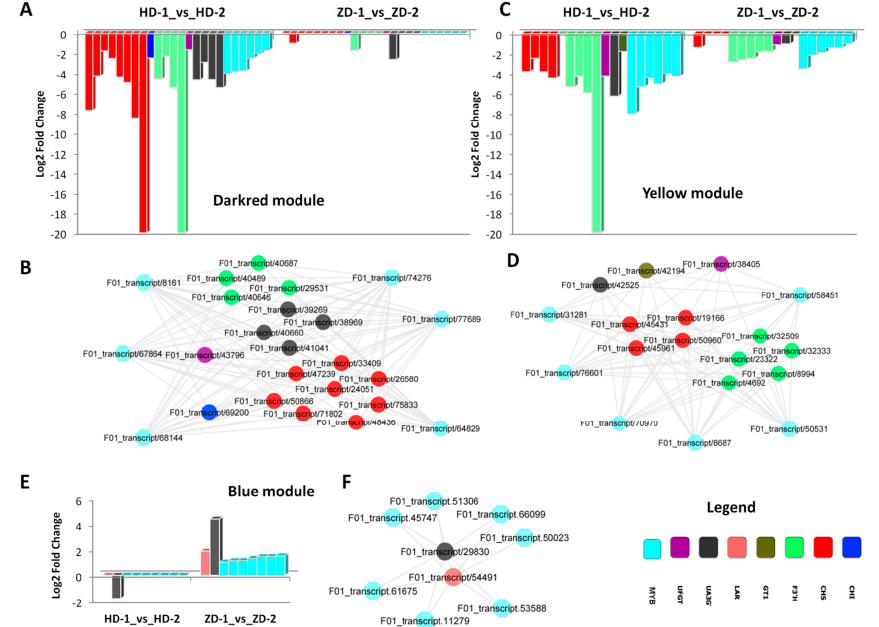
Figure 6. Gene co-expression analysis of the MYB regulators and their target genes related to the flavonoid–anthocyanin biosynthesis pathways in L. indica . ( A–B ) expression fold change and network of the genes co-expressed in the dark red module; ( B–C ) expression fold change and network of the genes co-expressed in the yellow module; ( D–E ) expression fold change and network of the genes co-expressed in the blue module. HD represents the cultivar Lagerstroemia Dynamite, while ZD represents the cultivar Lagerstroemia Ebony Embers.